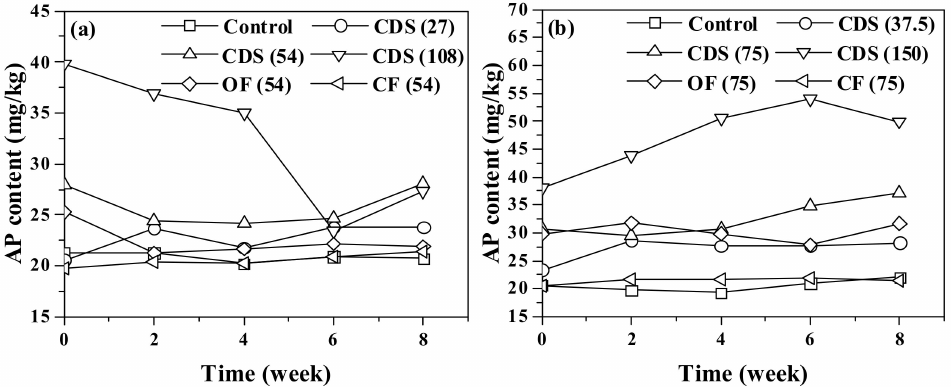
Figure 5. AP in soil affected by application of co-digestion sludge (( a ): phase one, ( b ): phase two).